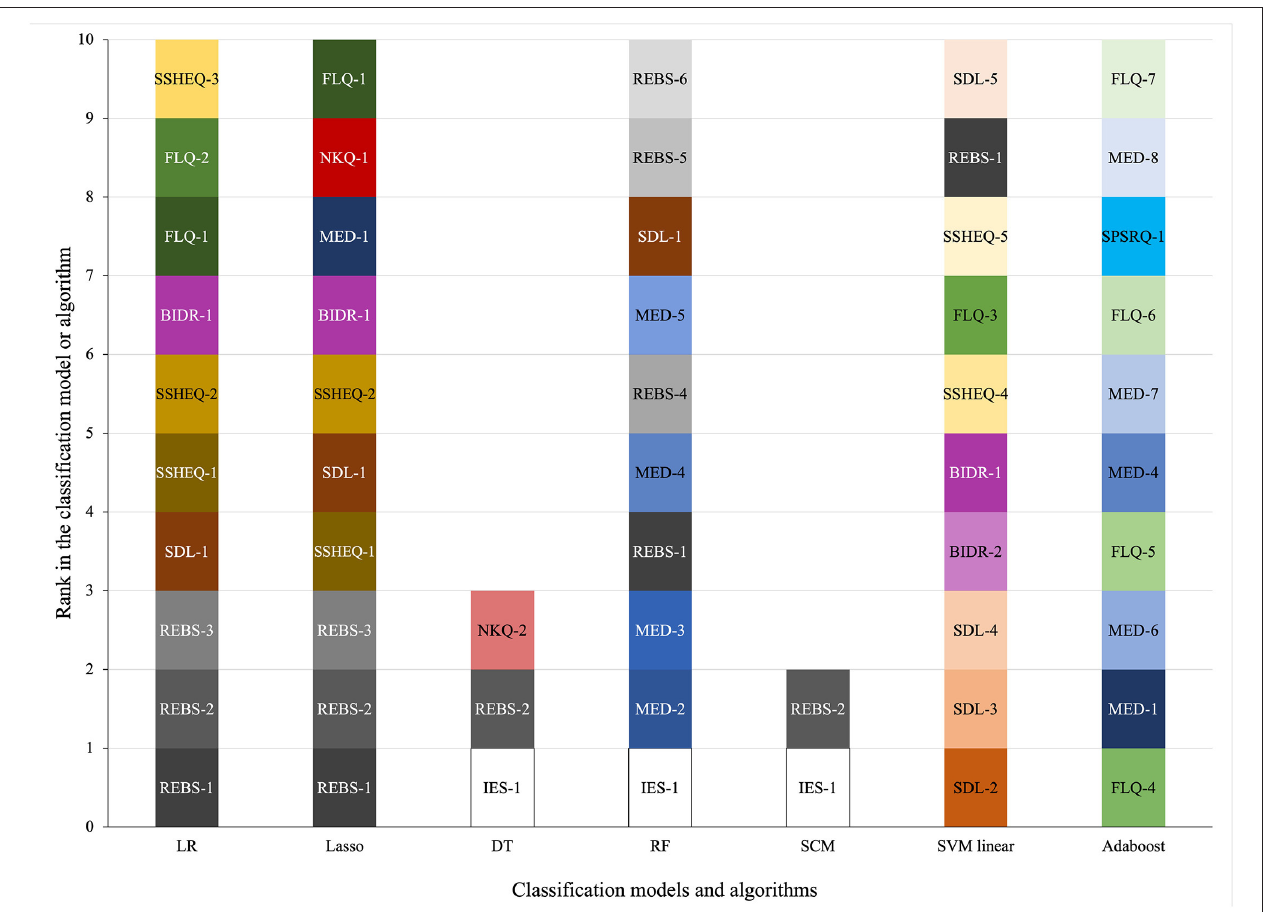
FIGURE 1 | Discriminant features retained in the logistic regression (LR) and Lasso models and in the decision tree (DT) , random forest (RF) , set-covering machine (SCM) , support vector machine (SVM) with a linear kernel and Adaboost machine learning algorithms to predict adequate vegetable and fruit consumption. Features are colour-coded according to the questionnaire to which they belong; different shades within a given color indicate that more than one feature of a questionnaire was retained; numbers indicate the rank of a given question from a given questionnaire retained in the model or algorithm. REBS, Regulation of Eating Behaviour Scale; SDL, Socioeconomic and demographic factors, eating and lifestyle habits; SSHEQ, Social support for healthy eating questionnaire; BIDR, Balanced inventory of desirable responding; FLQ, Food liking questionnaire; MED, Medical questionnaire; NKQ, Nutrition knowledge questionnaire; IES, Intuitive eating scale; SPSRQ, Sensitivity to punishment and sensitivity to reward